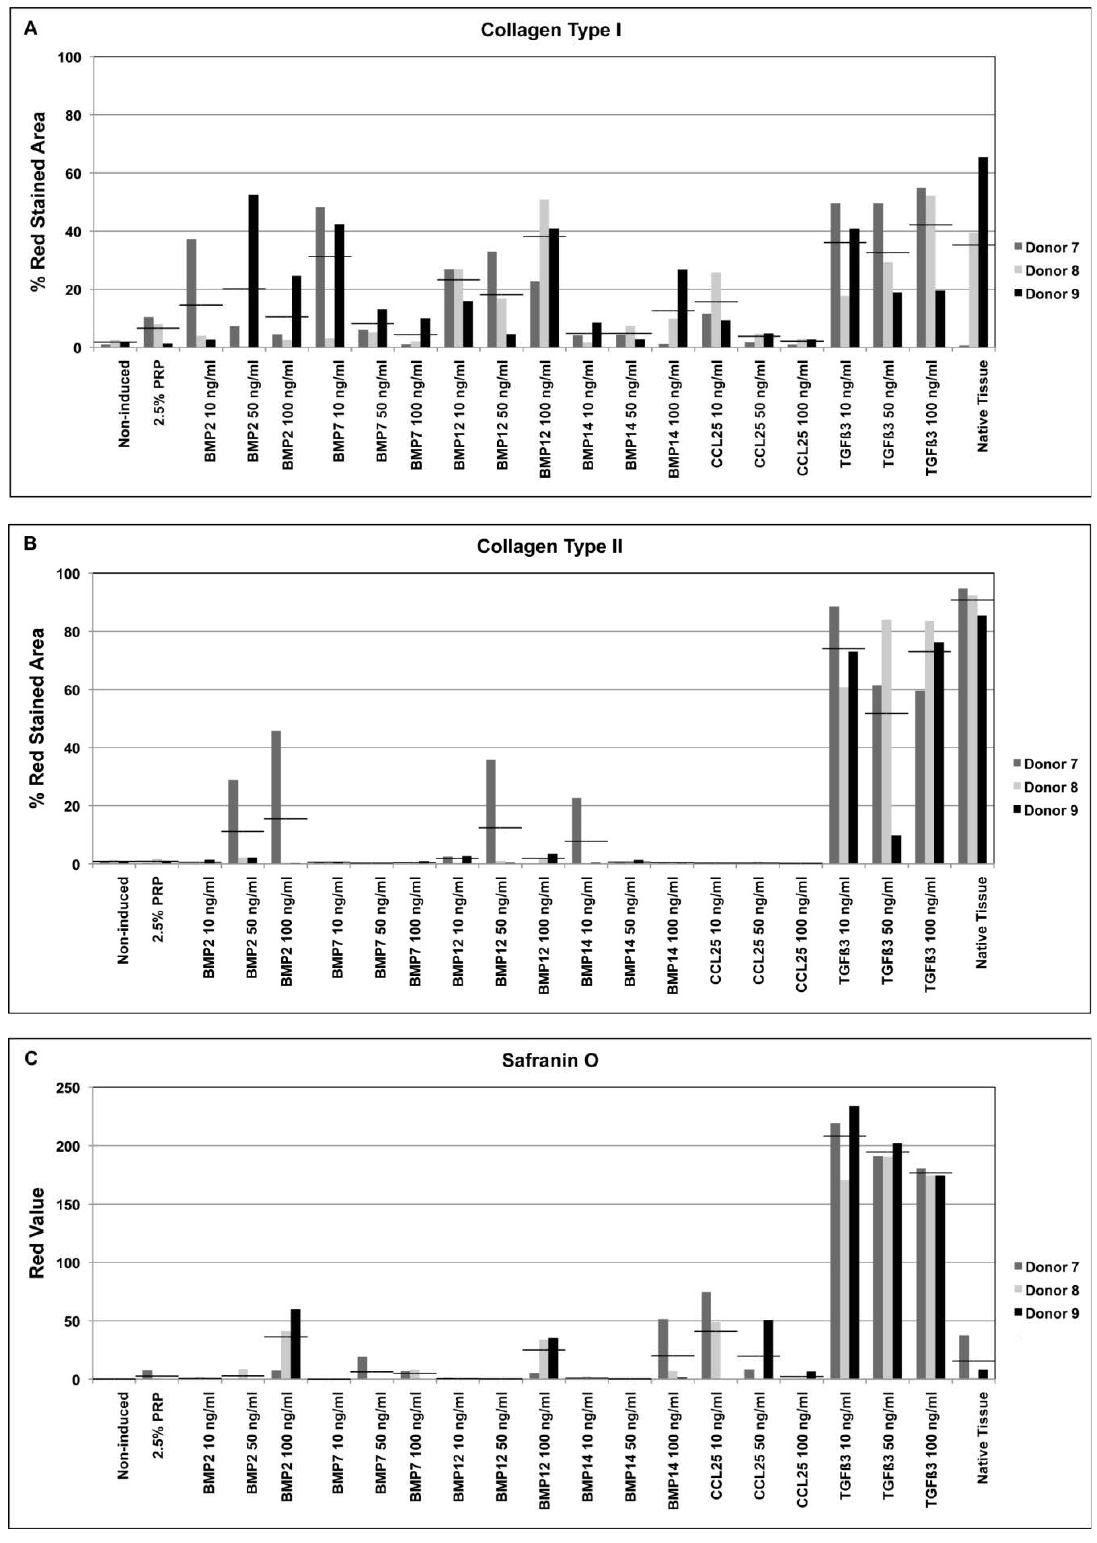
Figure 5. Histomorphometric analysis of collagen and proteoglycan formation. Collagen type I ( A ) and type II ( B ) stainings were analyzed histomorphometrically and the red stained areas calculated and given as a percentage of the sample. Histomorphometric analysis of safranin O staining determined the red value of the samples ( C ). Average values of the 3 donors were given as horizontal bars (___).